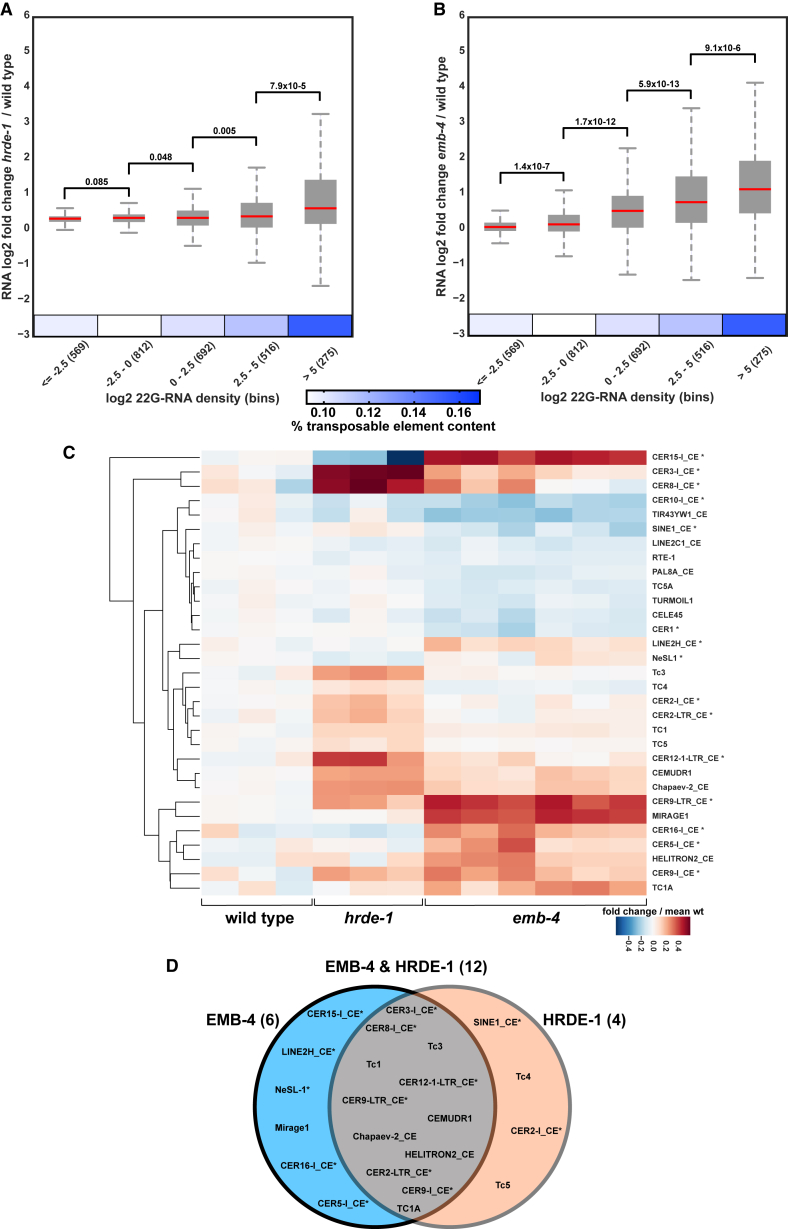
HRDE-1 and EMB-4 Are Required for the Suppression of Multiple Transposable Element Families(A and B) Genes in Figures 4F and 4G are grouped into bins of increasing 22G-RNA density as shown on the x axis (number of genes in each bin is shown in parentheses, boxes show the lower and upper quartiles, red line shows the median, and p values of two-sample t test are shown above the box plots). Heatmap shows percent abundance of transposable elements in each 22G-RNA bin.(C) Heatmap showing RNA fold change of transposable element families in wild-type, hrde-1, and emb-4 mutants compared with mean wild-type levels. Asterisks indicate retro-element families.(D) Venn diagram summarizing the overlap of upregulated transposable element families in hrde-1 and emb-4 mutant animals as shown in (C).